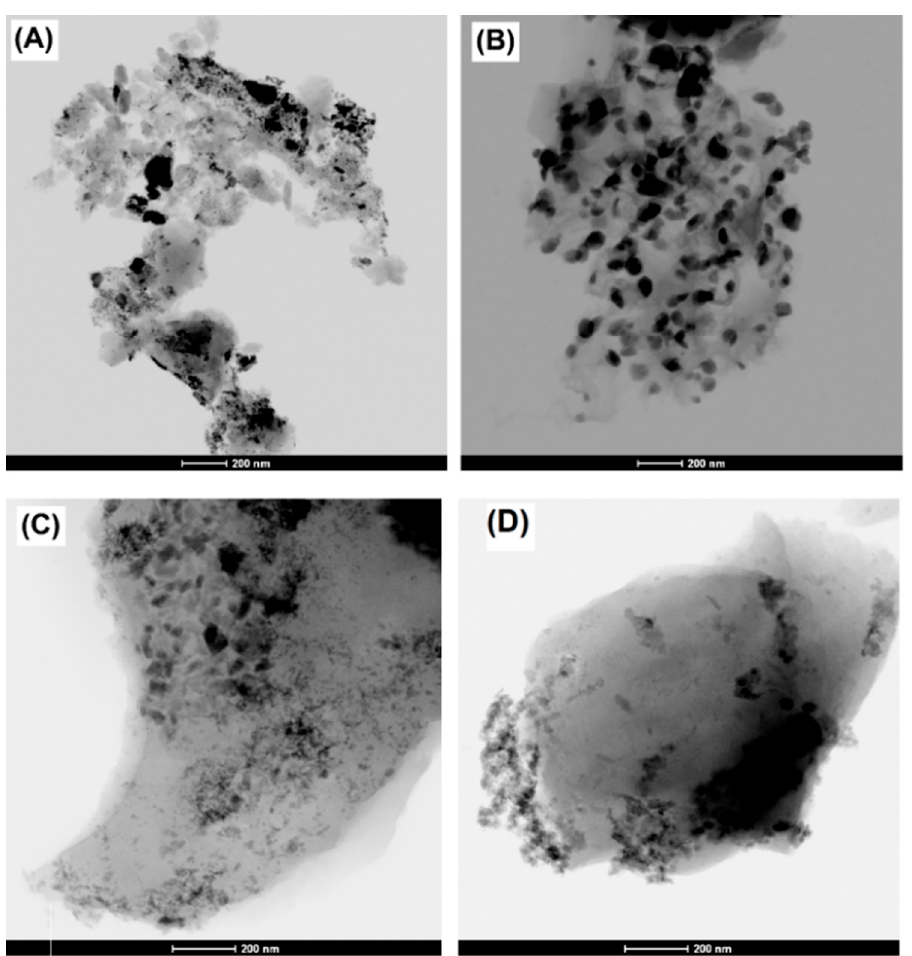
Figure 6. High-resolution transmission electron microscopy (HRTEM) images of ( A ) OSC-AC-Fe, ( B ) OS-AC/KOH-Fe, ( C ) SDC-AC-Fe, and ( D ) N-Fe catalysts.